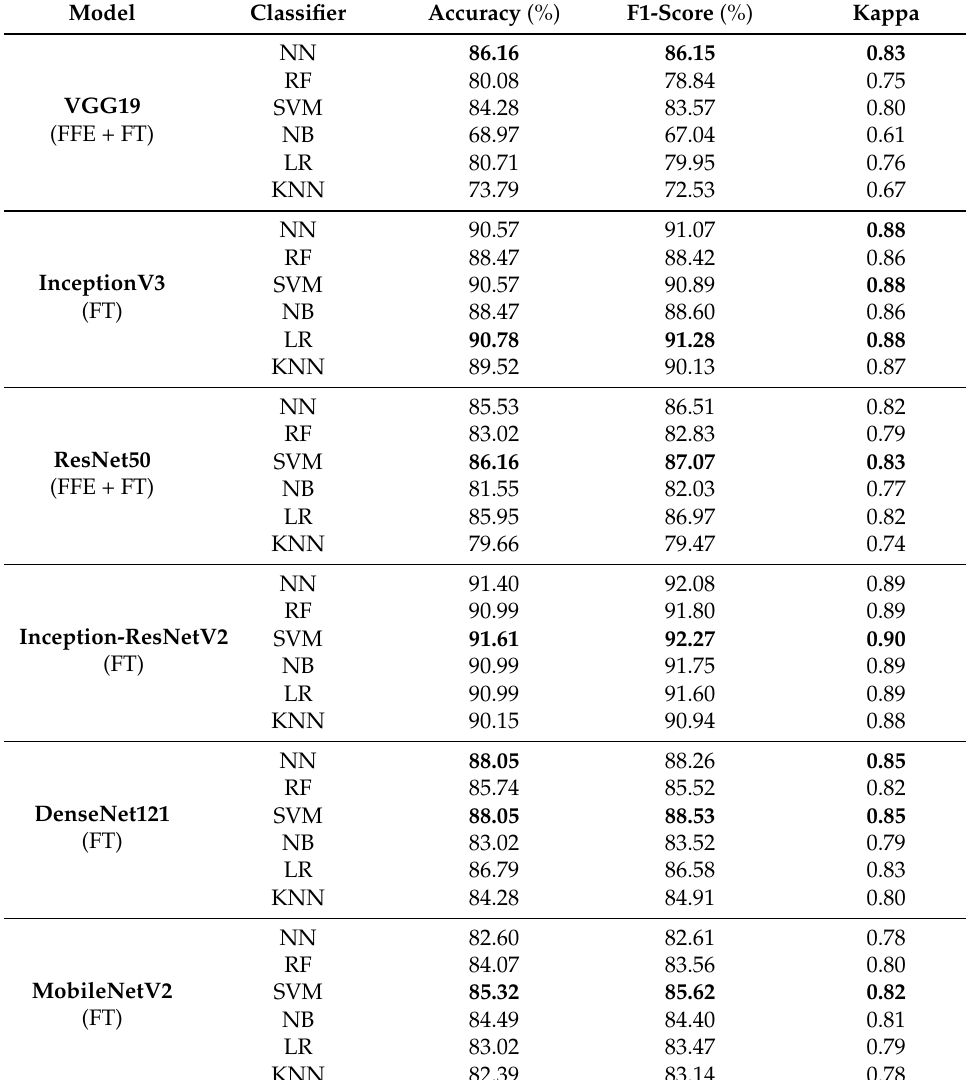
Table 6. Performance of machine learning classifiers on the test